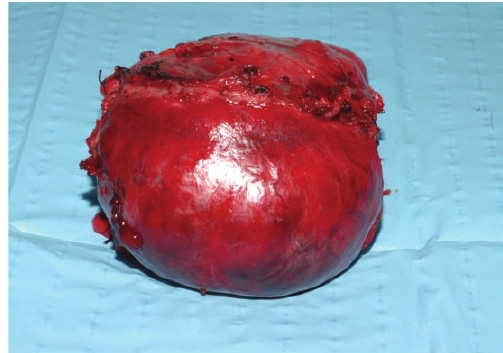
Figure 7: Resected paraadnexal extra-adrenal sympathetic para-